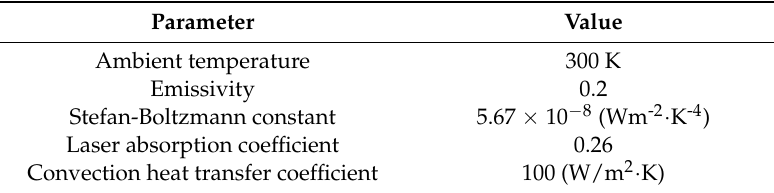
Table 3. Parameters used for calculation, data from